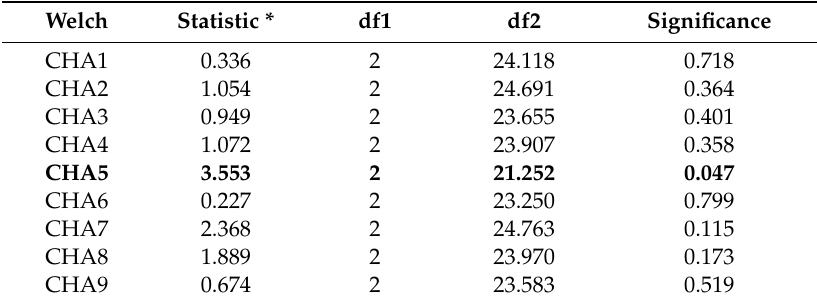
Table 4. Results of Welch ANOVA (robust tests of equality of means).